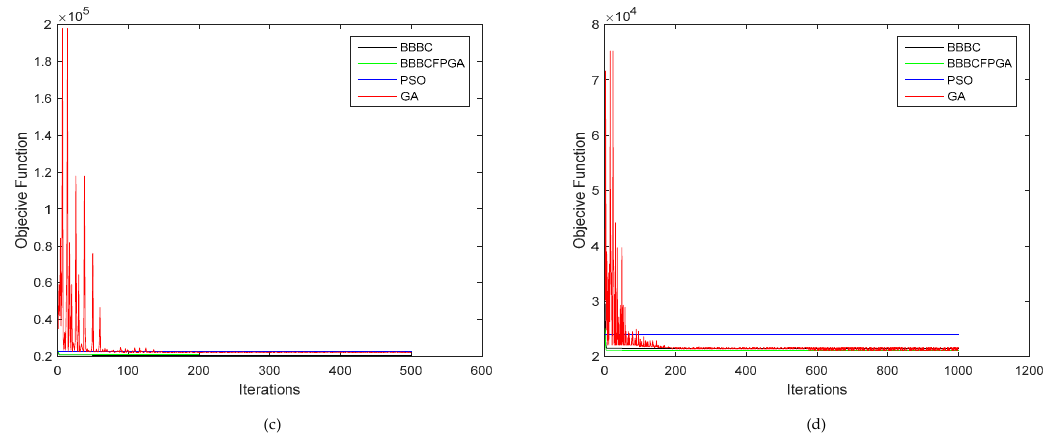
Figure 12. Objective function convergence for all four optimization methods and for different number of iterations ( a , b , c , and d for 100, 200, 500, and 1000 iterations, respectively).